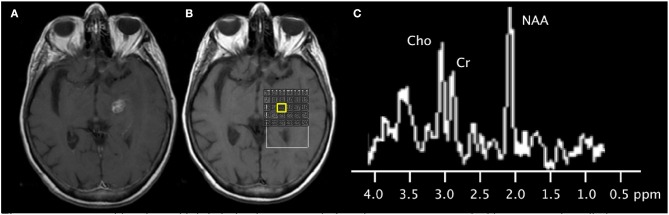
79-years-old patient with left thalamic metastasis from lung cancer treated with stereotactic radiotherapy. (A) Post-contrast T1-weighted image shows the treated enhancing lesion. (B) Multi-voxel 2D magnetic resonance spectroscopy acquired at 3T with grid placed on the lesion. (C) Spectra (from the voxel highlighted in yellow) shows mild elevation of the choline peak, slightly increased Cho/Cr ratio, slightly increased Cho/NAA ratio, and normal NAA/Cr ratio. Subsequent follow-up MRI showed shrinkage of the contrast-enhancing mass (not shown), supporting the diagnosis of radiation necrosis.